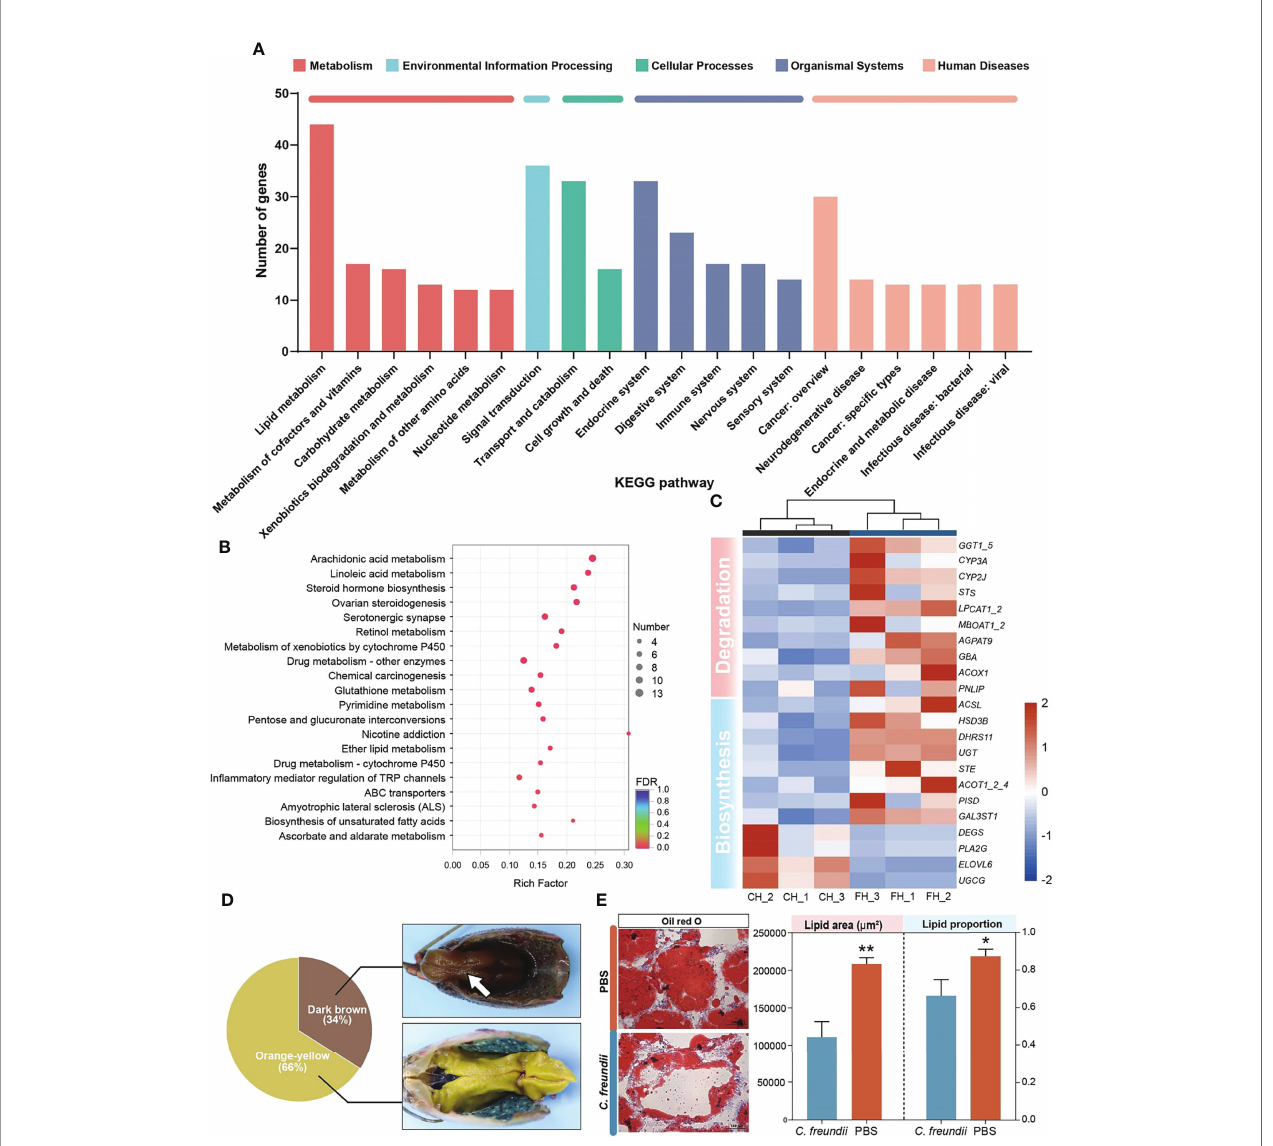
FIGURE 3 | DEGs analysis and validation. (A) KEGG annotation of DEGs. (B) Top 20 pathways enriched in differentially expressed genes (DEGs) by KEGG. The color and size of the dots indicate FDR and DEG numbers, respectively. (C) Visual heat map of DEGs related to lipid metabolism based on expression data. (D) Gross observation of the hepatopancreas of cray fi sh. Dark brown hepatopancreas (White arrow). (E) Oil red O staining of the hepatopancreas in the two groups and lipid staining area and proportion of lipid to cell parenchyma (×200). *, **represent P < 0.05 and 0.01, ( Figure 3E ). Transcriptome results suggest that C. freundii infection may lead to imbalance of lipid metabolism in cray fi sh hepatopancreas and induce lipid degradation.